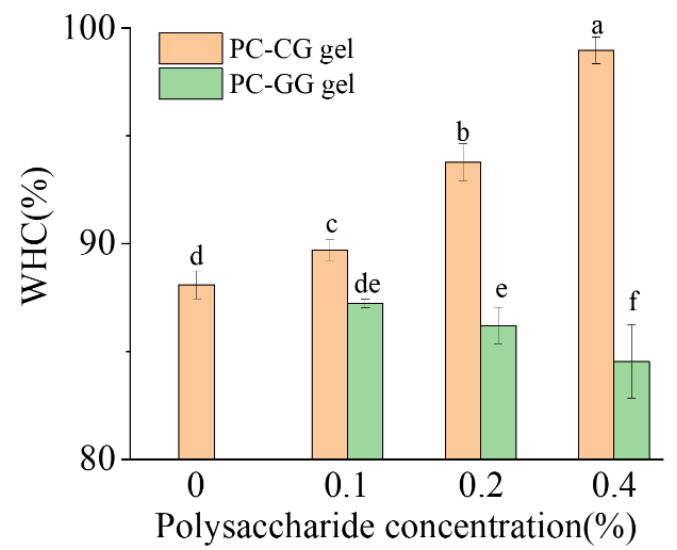
Figure 6. The effect of different κ -carrageenan/guar gum addition on the water holding capacity of phycocyanin gel. Each value represents the mean ± standard deviation (n = 3). The values of different letters were significantly different ( p < 0.05).